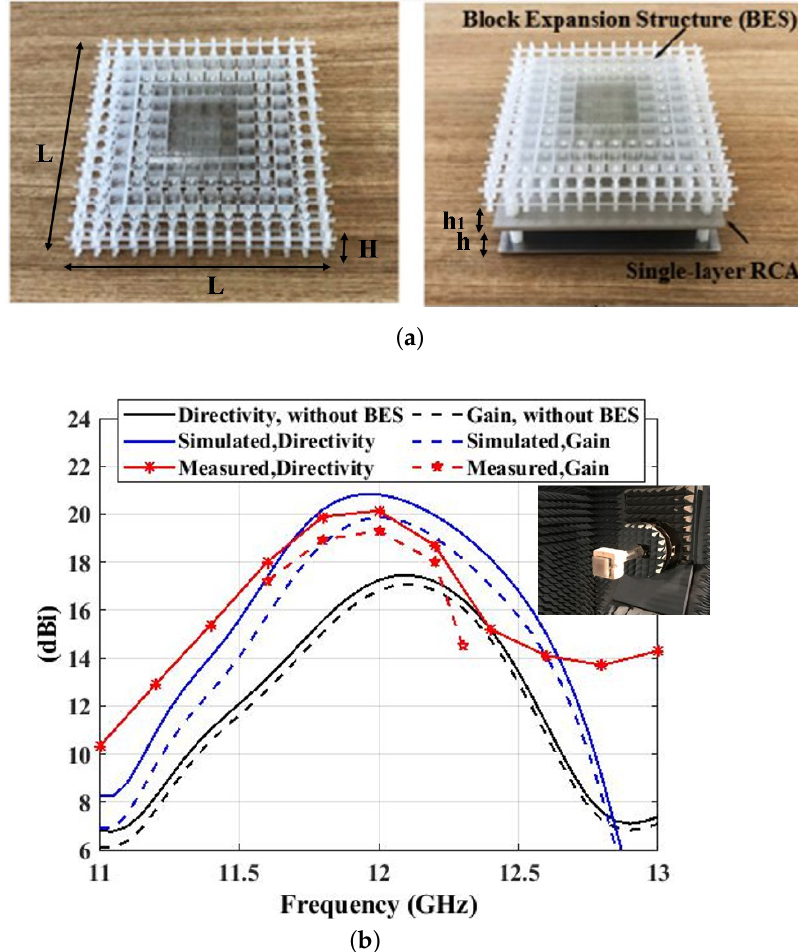
Figure 6. ( a ) Fabricated prototype of the dual-layer BES manufactured using stereolithographic process (left) and the RCA with the BES installed (right). ( b ) Simulated and measured broadside directivity and gain of the RCA with and without BES attached. The inset shows the RCA under test at AusAMF.